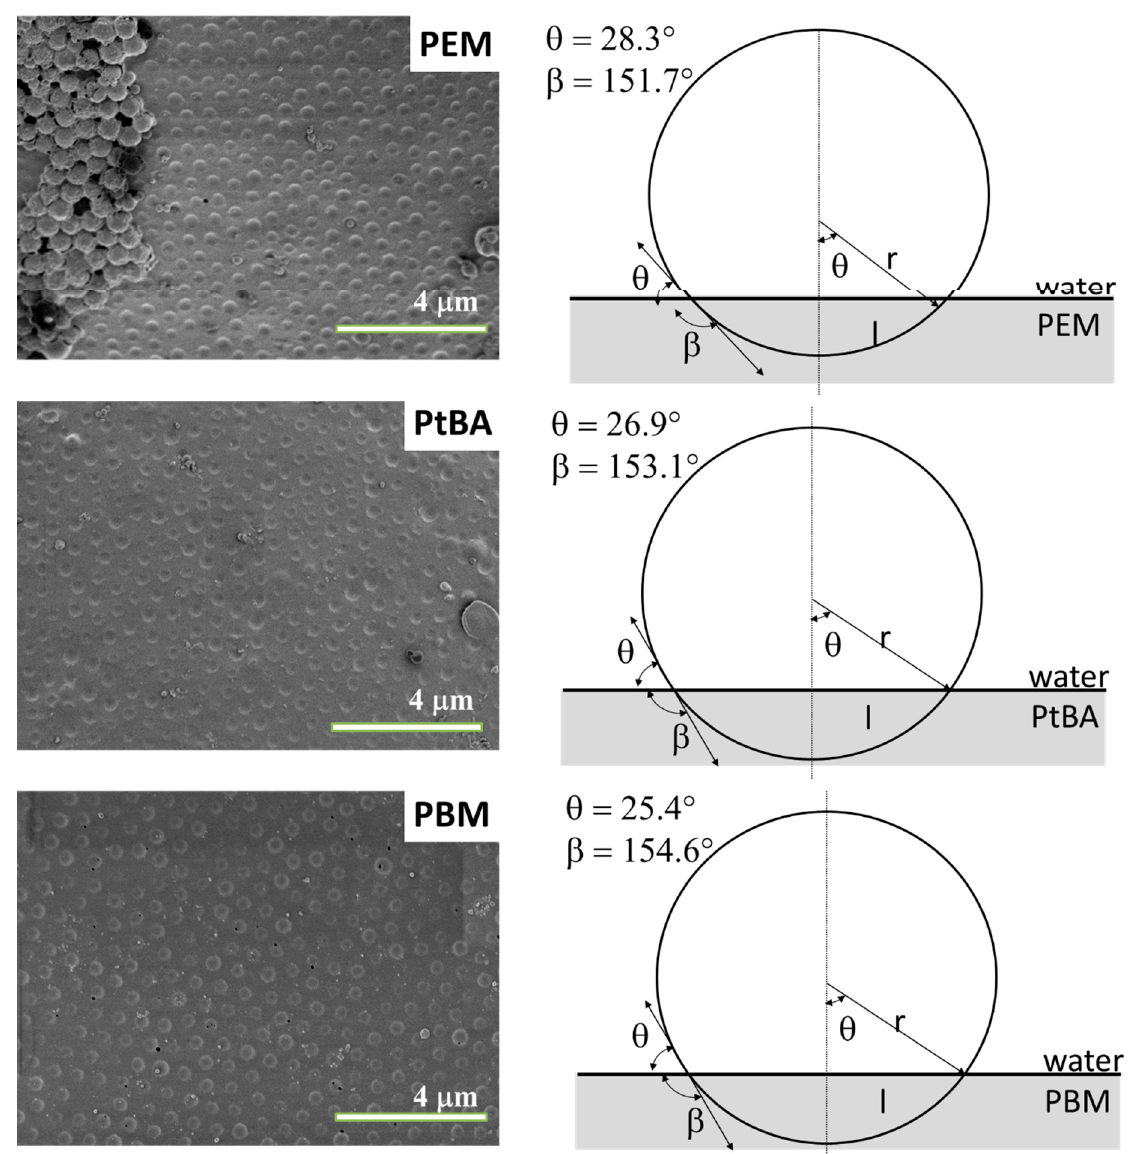
Figure 4. SEM images of the circular traces left by NP-Gly on the surface of PEM, PtBA and PBM microspheres. The cartoons on the right represent the immersion depth of the nanoparticles at the interface that can be fully described by the contact angle values θ with the water and β with the organic phase. In the image the l represents the diameter of the circular trace determined by SEM, and r represents the radius of the nanoparticle.